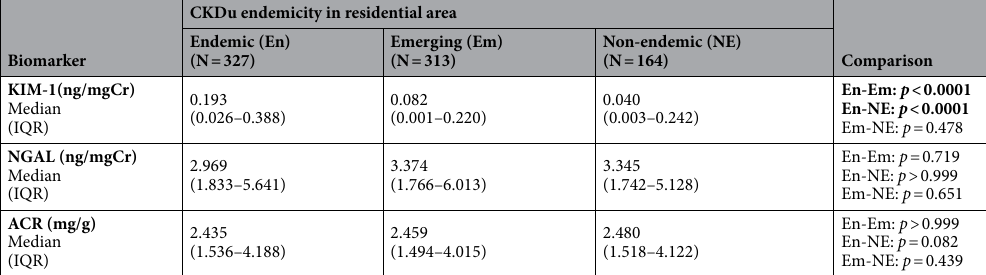
Table 2. Levels of KIM-1, NGAL, and ACR in children from CKDu endemic, emerging, and non-endemic regions. significant comparisons are shown in bold. Biomarker levels for children in the three study groups are expressed as median with inter quartile range (IQR) and inter-group comparison is expressed in terms of Kruskal–Wallis one-way analysis followed by Dunn’s multiple comparison test. KIM-1 kidney injury